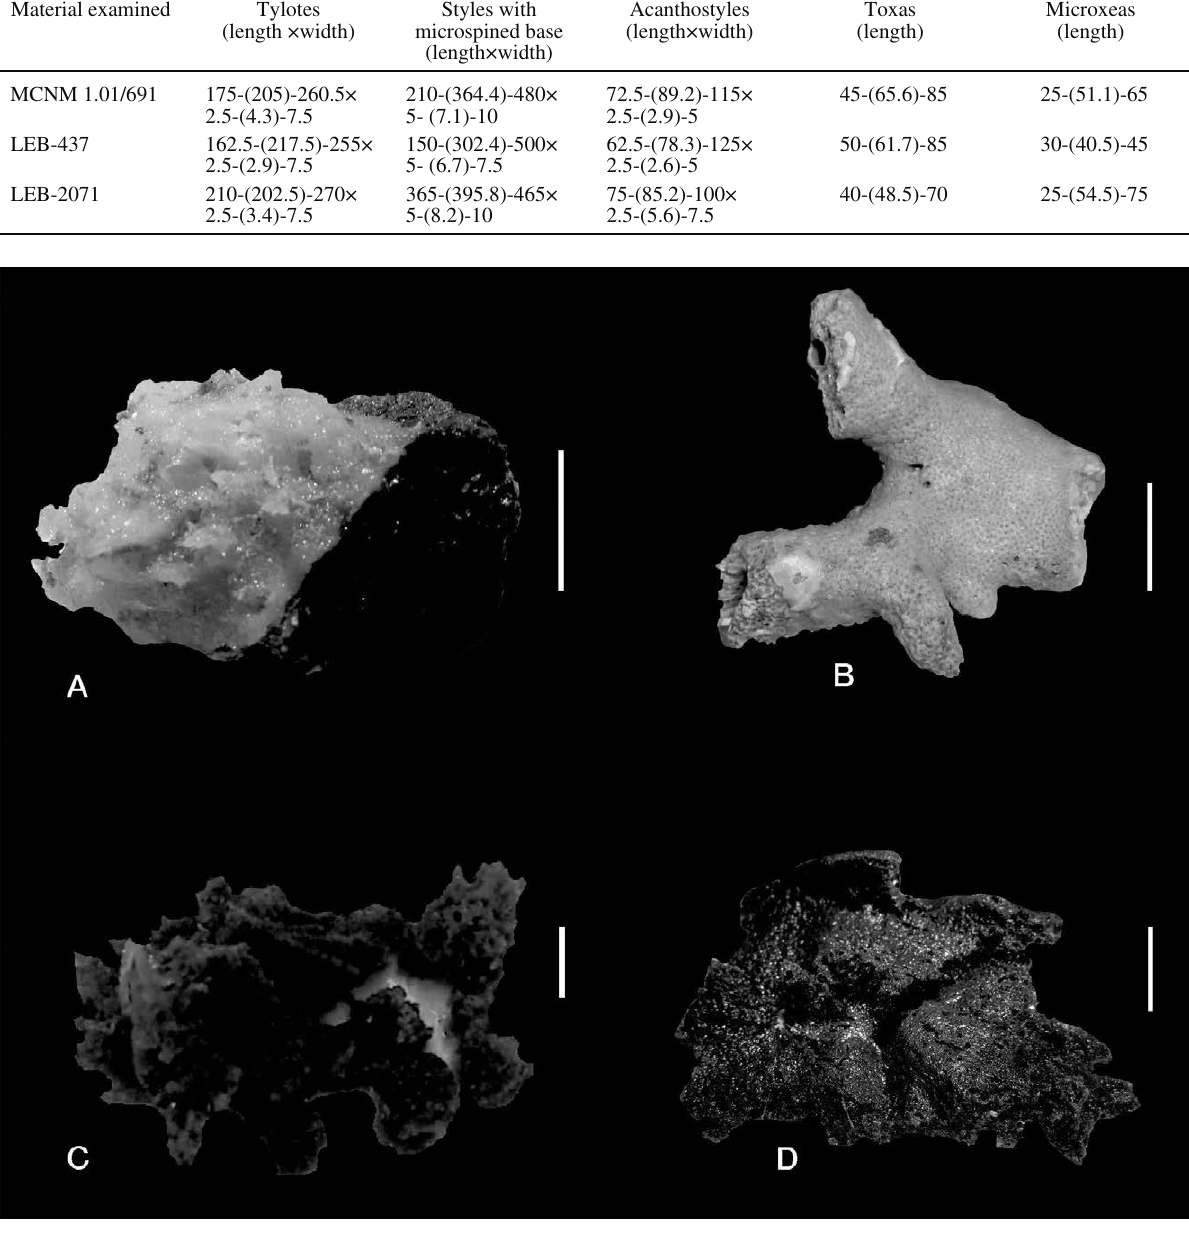
Fig . 9. – A, Megaciella microtoxa (Dickinson, 1945). Fragment of the neotype (AHF 556-36). B, Megaciella toxispinosa n. sp. Preserved specimen growing over coral fragment. C, Iophon indentatum Wilson, 1904. Fragment of Allan Hancock Pacific Expedition (AHF 560-36). D, Iophon bipocillum n. sp. Fragment of a preserved specimen. Scale: A, D, 2 μm; B, 3 μm; C, 1